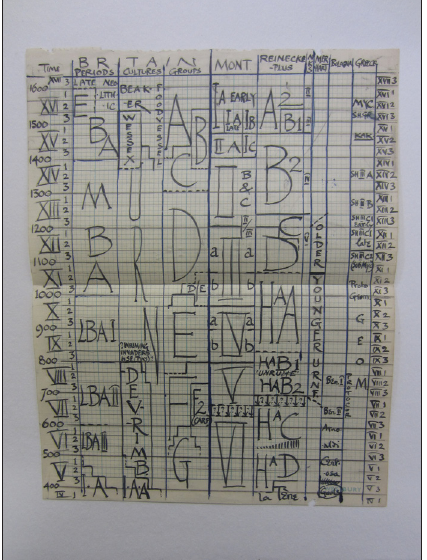
Figure 1: Draft of one of Childe’s chrono- logical charts for The Dawn done in the Modernist style popularised by Sir Arthur Evans in his work. Undated. (Photo UCL Institute of